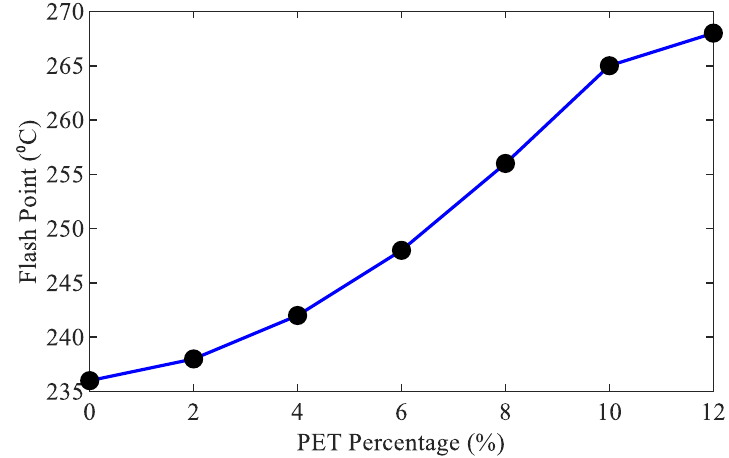
Fig. 20 Effect of PET on flash point of bitumen